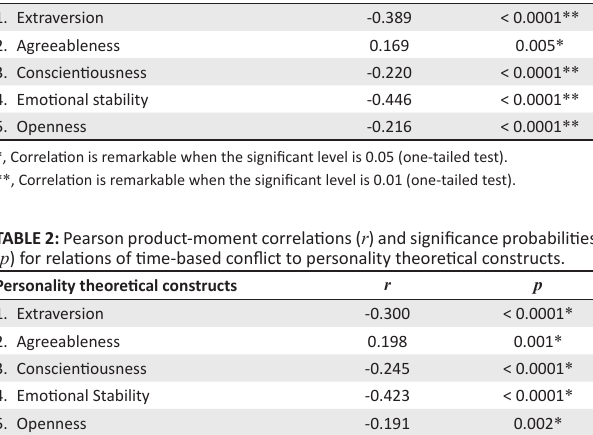
TABLE 1: Pearson product-moment correlations ( r ) and significance probabilities ( p ) for relations of work – family conflict to personality theoretical constructs. Personality theoretical constructs